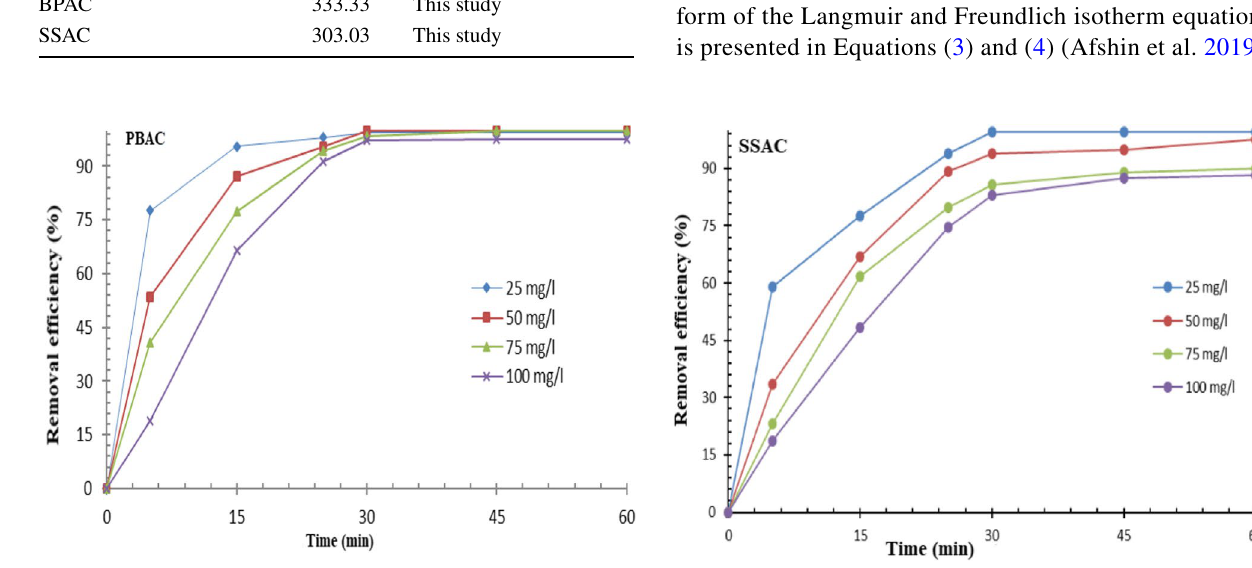
Fig. 7 The effect of time and concentration of BB41 on adsorption by PBAC and